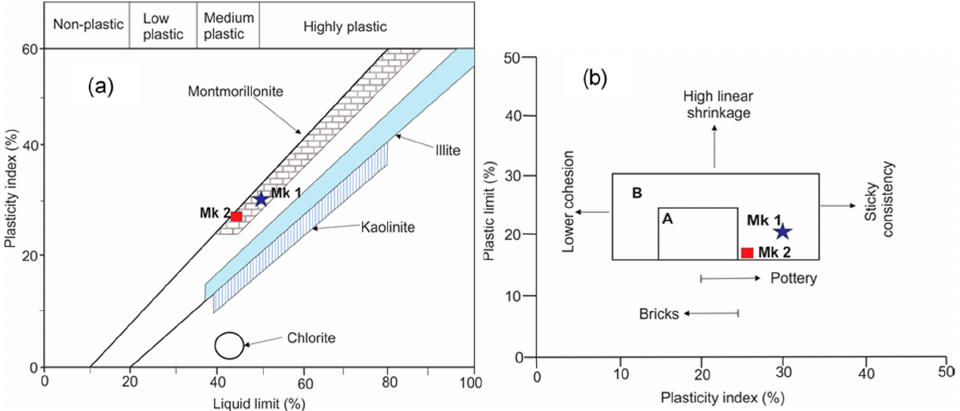
Figure 3. Consistency limits of raw clay materials: ( a ) According to Holtz and Kovacs diagram [33]; ( b ) clay workability chart [34].